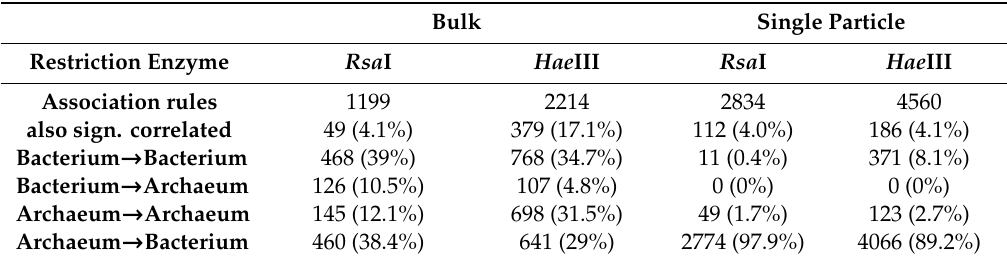
Table 4. Association rule